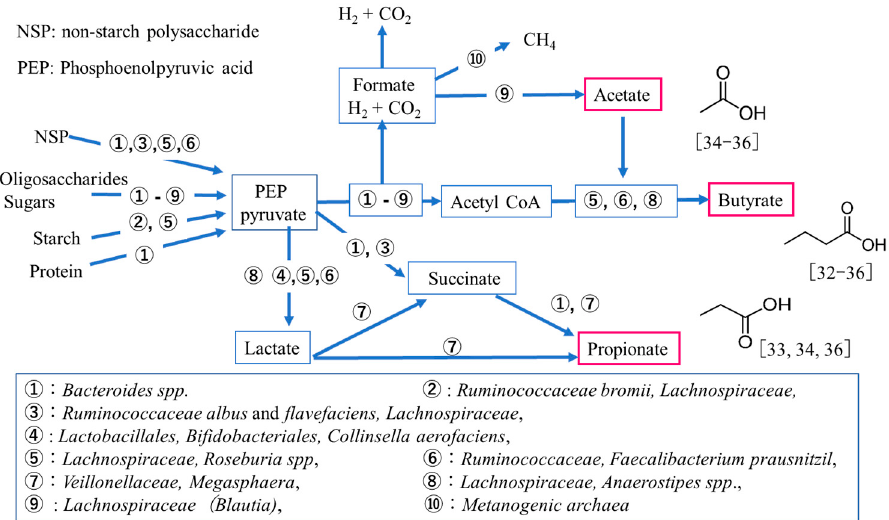
Figure 1. Schematic of intestinal short-chain fatty acid production in human colonic bacteria [30– 36].